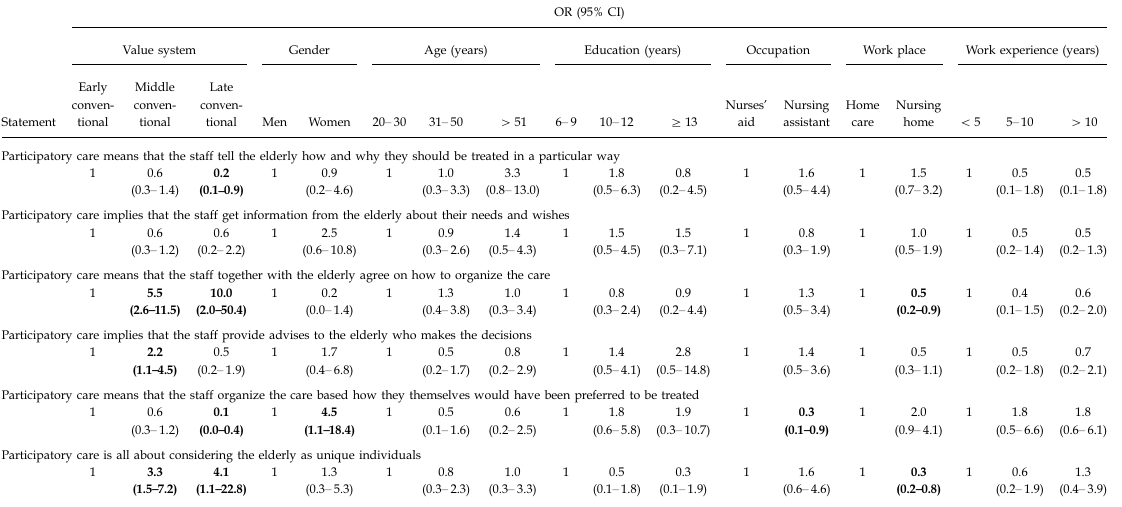
Table 4. Binary logistic regression models for predicting nursing assistants’ and nurses’ aides’ views on participatory care